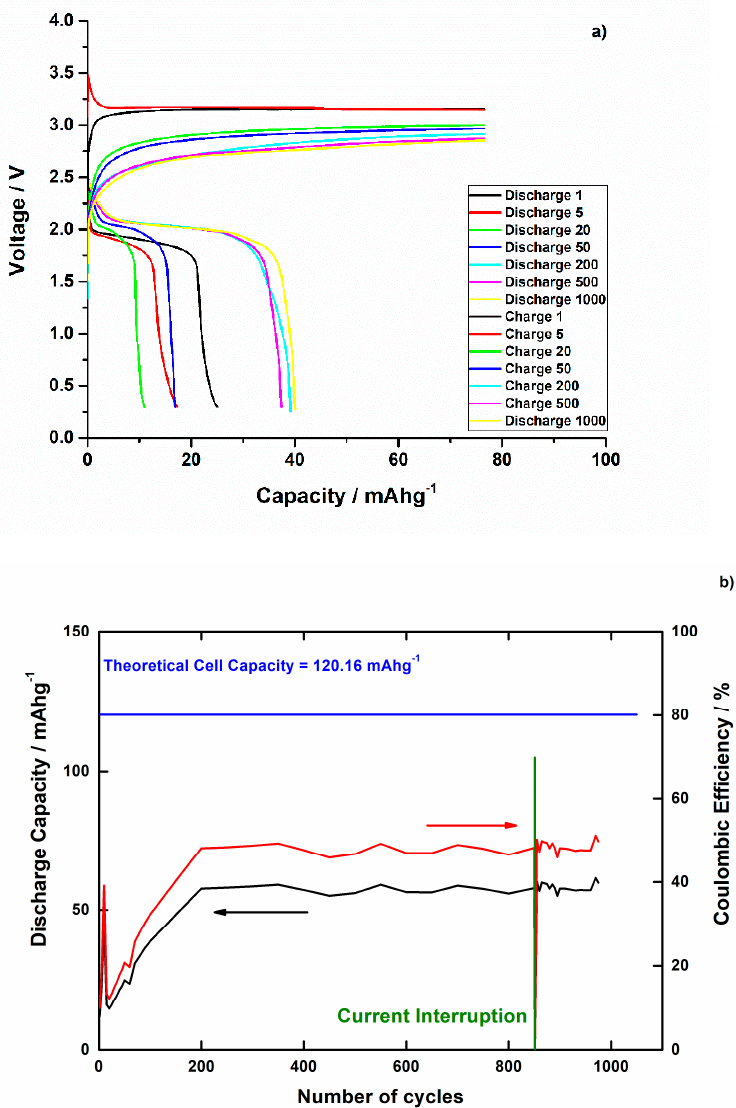
Figure 7. Electrochemical performance of nanostructured lead-acid electrodes operating at − 20 ± 2 °C and 10 C: ( a ) charging and discharging curves of different cycles, and ( b ) cycling efficiency on discharging and discharge